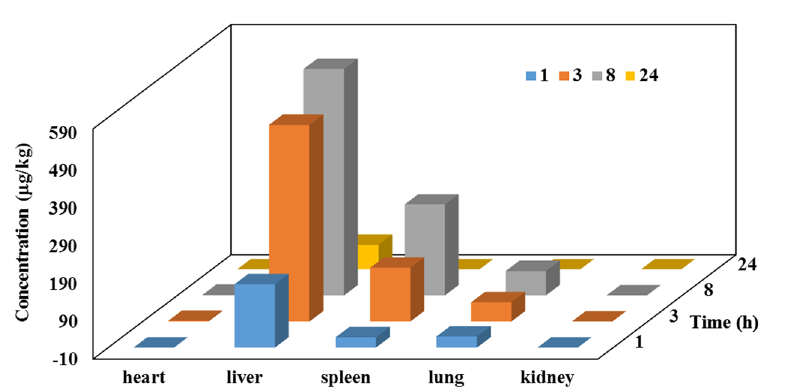
Figure 4. Size distribution histograms of 60- and 80-nm GNPs obtained by LA-SP-ICP-MS under optimal conditions.